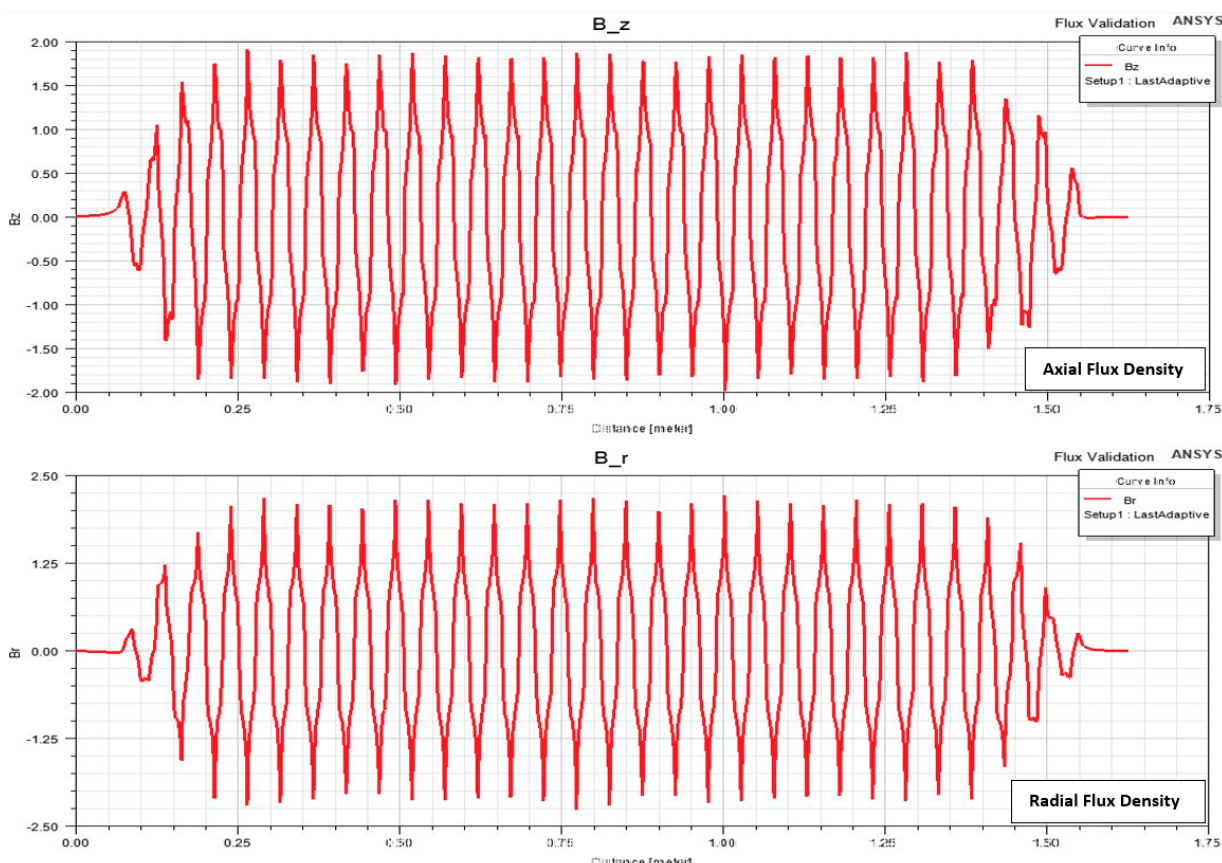
Figure 7. Multiple poles magnetic flux plots for the entire ring & shaft framework with segmented magnetic arrangement (Ansys electronics desktop)—Presenting interaction condition where the peak magnetic flux for each pole is different.